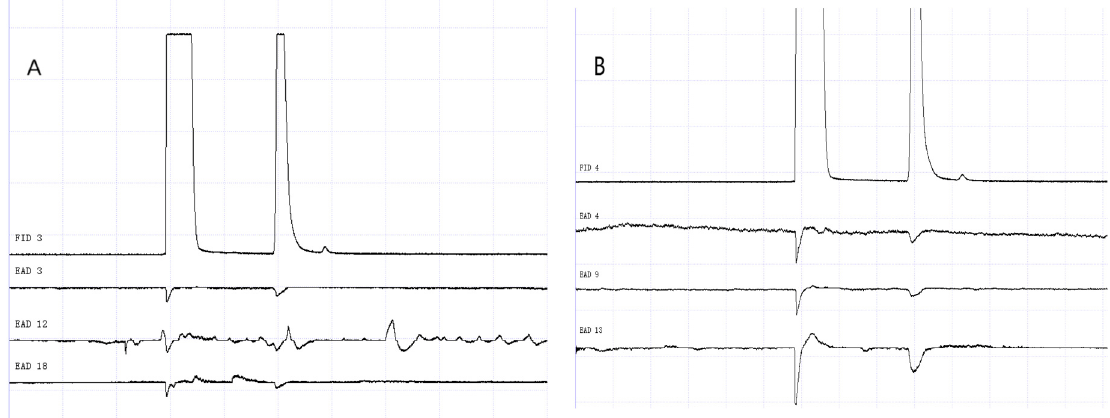
Figure 13. GC-EAD responses of 1-day-old W. magnifica to 1-octen-3-ol. ( A ) Male. ( B ) Female.